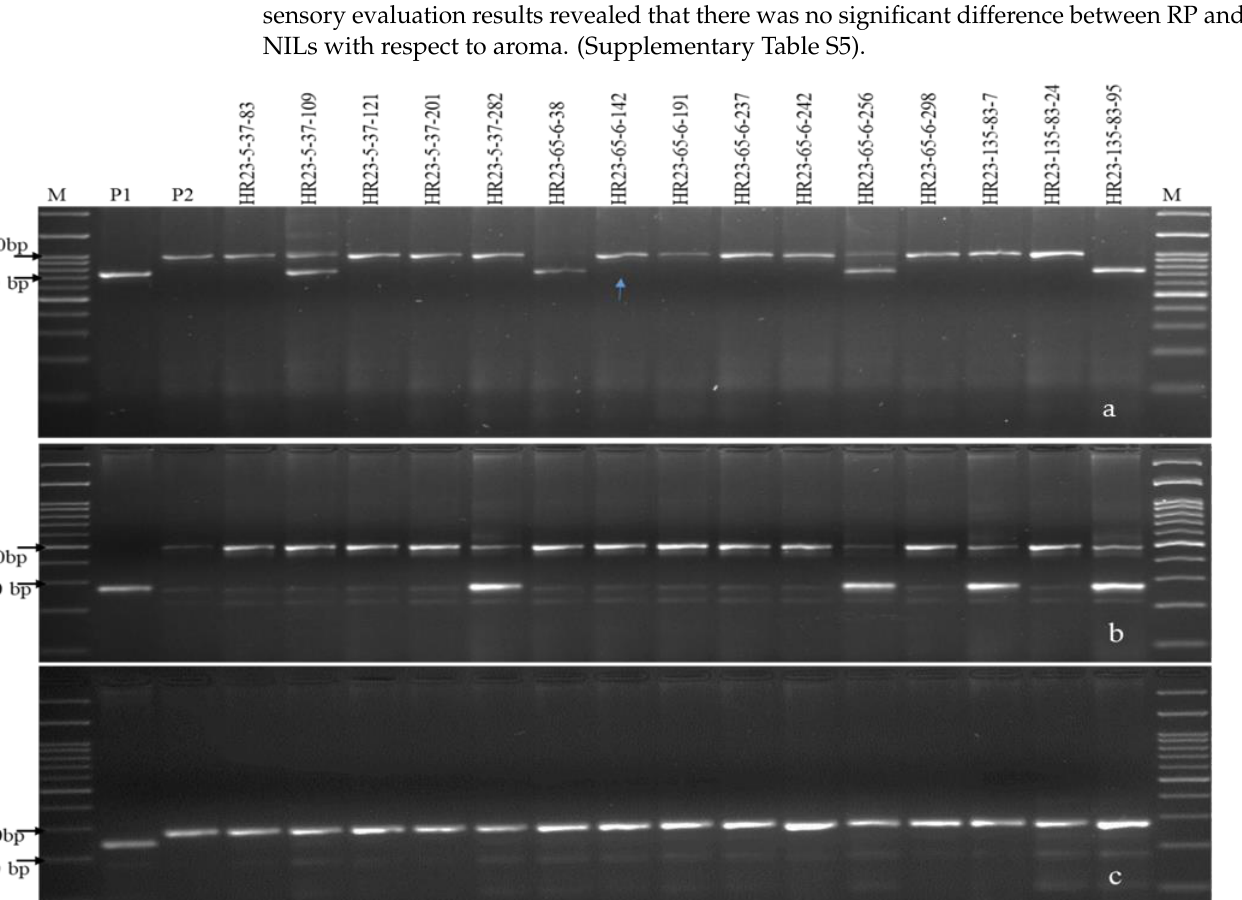
Figure 2. PCR amplification of BB resistance gene (s) in BC 1 F 1. ( a ) Amplicons of the Xa21 gene using pTA248 primer. ( b ) Amplicons of the xal3 gene using xal3prom primer. ( c ) Amplicons of the xa5 gene using RM122 primer; M, marker; P1, donor parent (IRBB66); P2, recurrent parent (HUR 917), Lanes 4 – 26 represent BC 1 F 1 plants; vertical arrows indicate a positive plant heterozygote for all tar- geted genes.